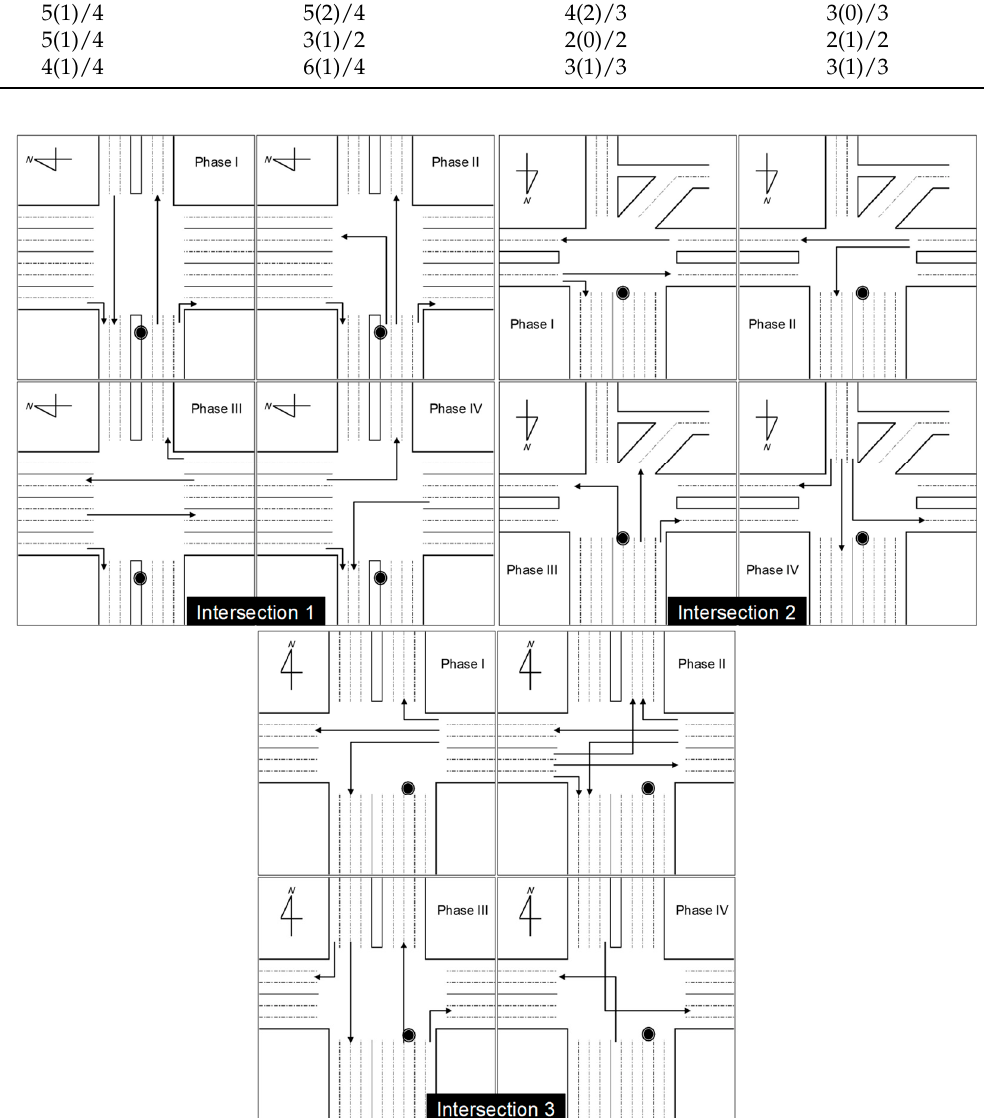
Figure 2. Traffic flow in each of four green light phases (phase I to phase IV) during traffic signal cycles and the measurement point at each intersection (black circles).